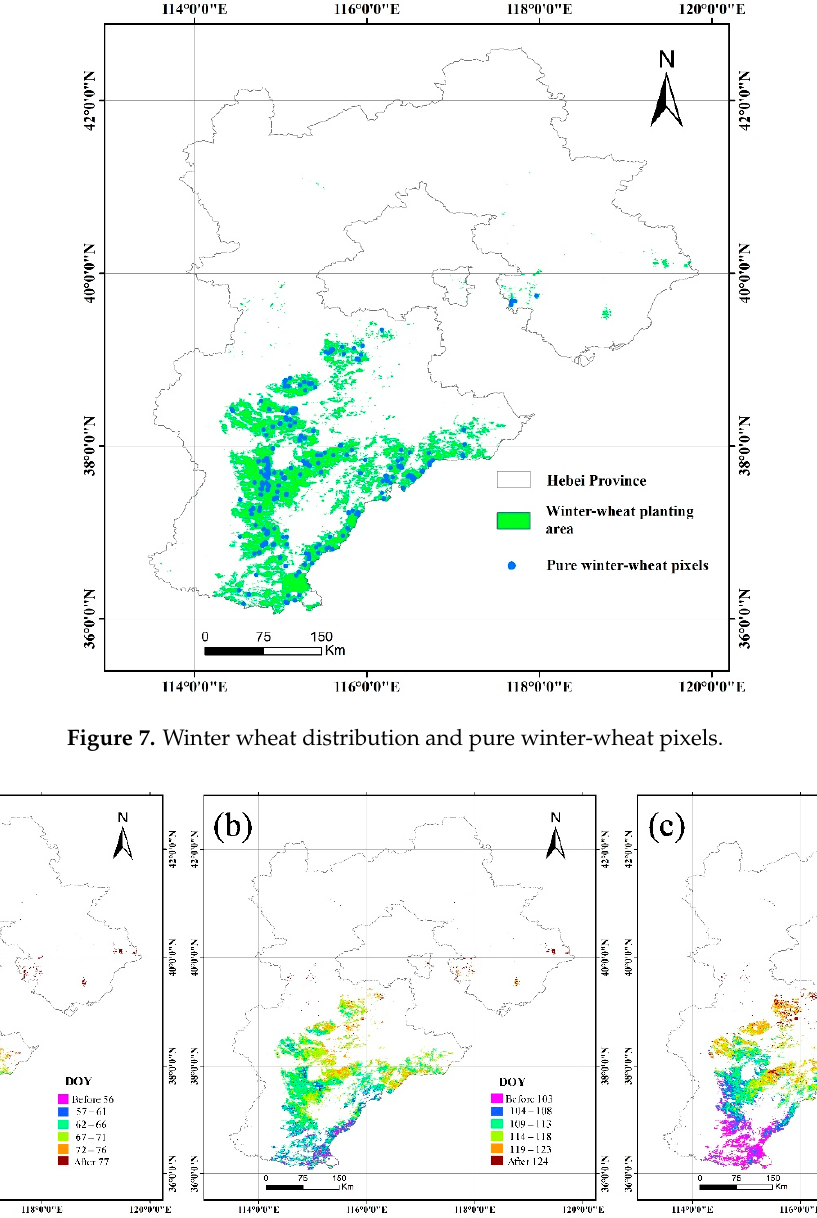
Figure 9. The validation of the satellite-derived winter-wheat phenological phases obtained using the TWDTW algorithm via comparison with ground-observed data. ( a ) GUD. ( b ) HD. ( c ) MD. The black line is the 1:1 line. 4.4. Relationship between Winter-Wheat Phenology Pattern and Geographical Location To investigate the distribution pattern of winter-wheat phenological phases, we an- alyzed the changes in the distribution of the main phenological phases of winter-wheat in Hebei Province with longitude and latitude. The results are shown in Figure 10. From this figure, it can be seen that the GUD, HD, and MD have a high correlation with latitude, with R 2 values of 0.658, 0.588, and 0.649, respectively. By establishing a linear regression equation, it was found that for each 1° increase in latitude, the GUD, HD, and MD are delayed by 4.84, 5.79, and 6.61 days, respectively (see Figure 10a, b, and c, respectively). The R 2 values of the GUD, HD, MD, with longitude are 0.258, 0.411, and 0.095, respectively (Figure 10d, e, and f, respectively). The HD has the strongest correlation with longitude. According to the regression equation, for each 1° increase in longitude, the HD is delayed by 5.2 days. The correlation between MD and longitude is the weakest, with an R 2 of only 0.095, indicating that MD does not change with longitude.